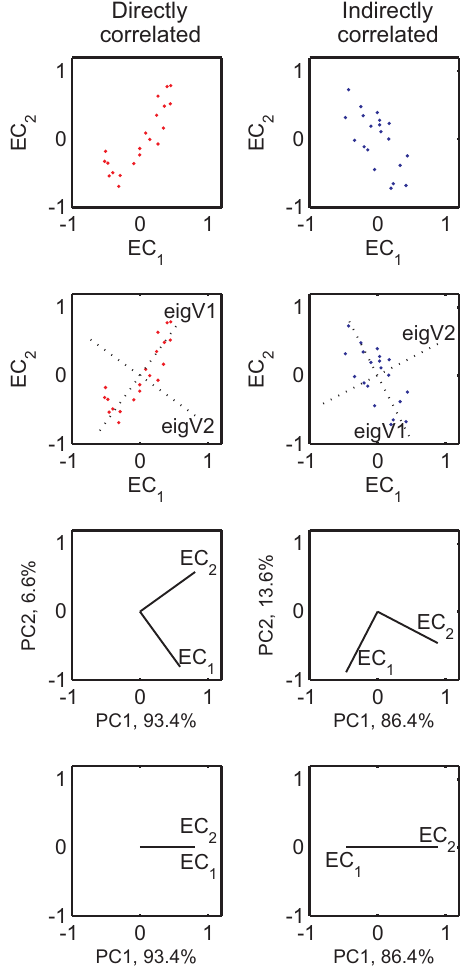
Fig. A1: Example showing the basic principles of Principal Fig. A1. Example showing the basic principles of principal compo- nent analysis and the application of PCA for FARM. left column: Component Analysis and the application of PCA for FARM. case 1; right column: case 2; first row: original data for EC 1 and EC 2 ; second row: original data with eigenvectors (“eigV”, dotted); third row: ECs expressed in terms of PC1 and PC2; fourth row: ECs expressed in terms of